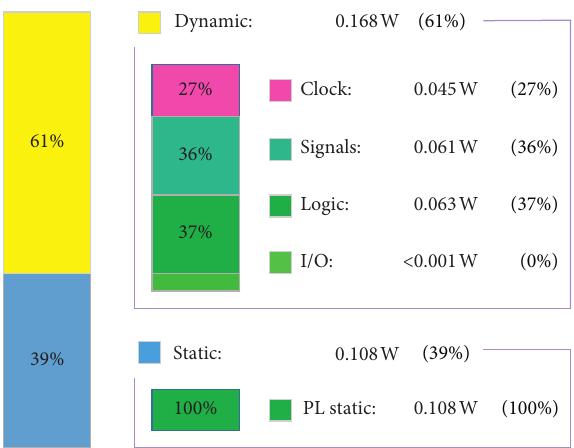
Figure 18: Power utilized by the system based on FPGA. Table 3: The Xilinx ZYNQ-XC7Z020 chip statistics of FPGA-based multistable modified fourth-order Chua’s chaotic system. FPGA